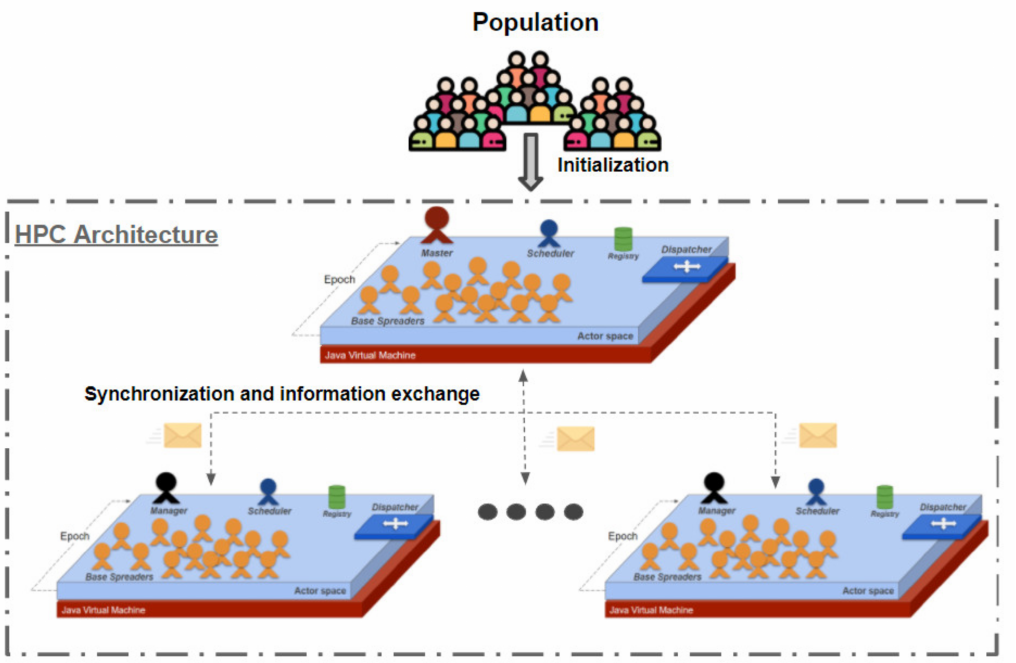
Figure 3. The simulator’s architecture on the High Performance Computing (HPC) architecture divides individuals in several actor spaces on different computational